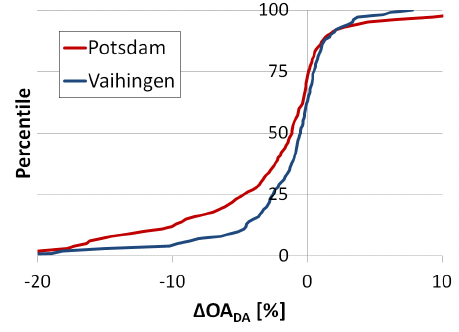
Figure 2: Percentile plots of the DA performance, measured by ∆OA DA , for the Vaihingen and Potsdam